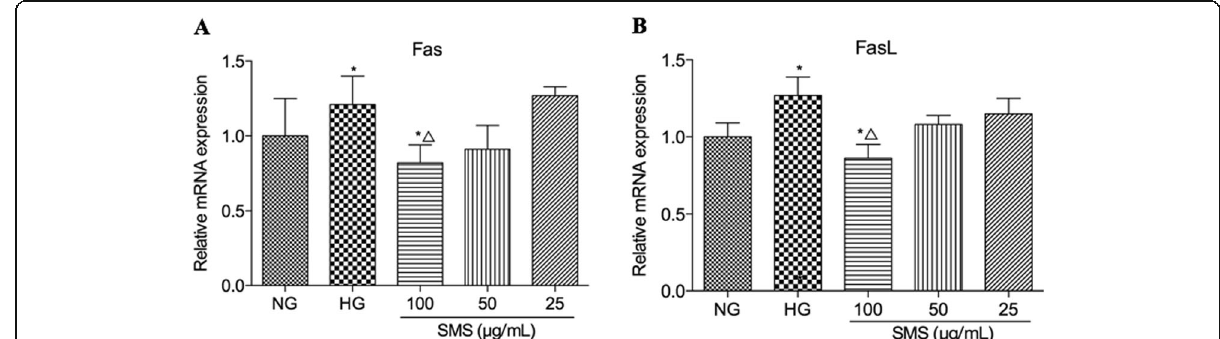
Fig. 6 Real-time PCR analysis for Fas and FasLgene expression in H9C2 cells. a RT-PCR analysis for Fas. b RT-PCR analysis for FasL. (* p < 0.05: vs. NG group; △ p < 0.05: vs. HG